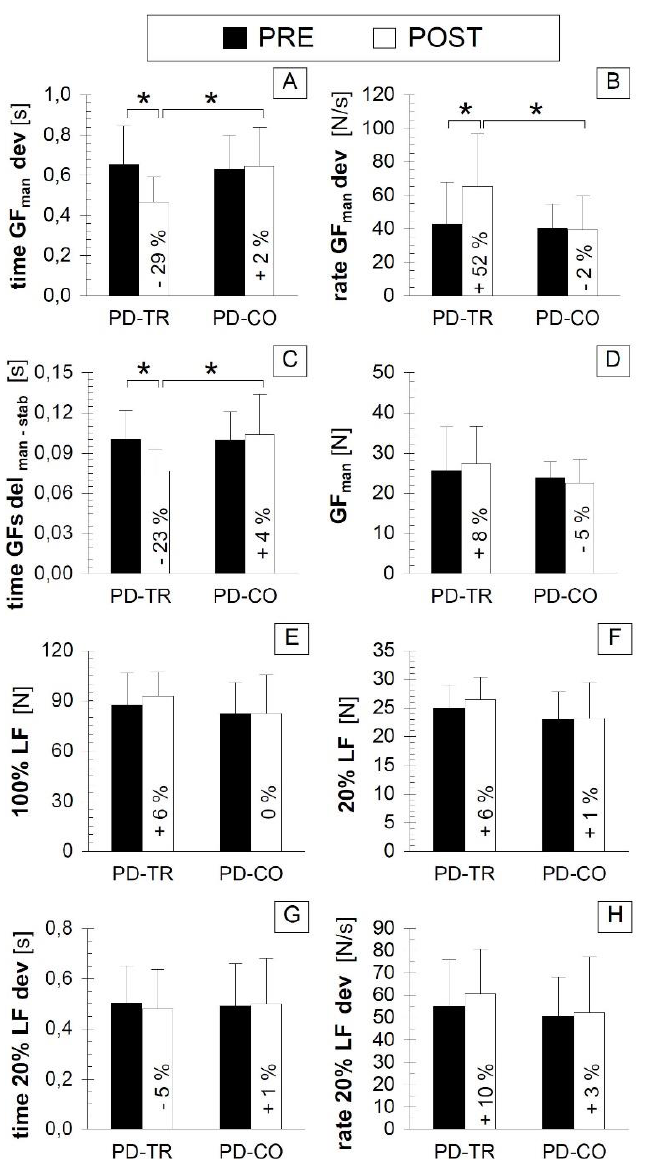
Figure 3. Comparison of the bimanual motor control outcomes between the two testing sessions and the two tested groups. ( A ) panel A presenting the values of time GFman dev; ( B ) panel B presenting the values of rate GFman dev; ( C ) panel C presenting the values of time GFs del man-stab ; ( D ) panel D presenting the values of GFman; ( E ) panel E presenting the values of 100% LF; ( F ) panel F presenting the values of 20% LF; ( G ) panel G presenting the values of time 20% LF dev; ( H ) panel H presenting the values of rate 20% LF dev. Abbreviations: PRE — testing session before the eight weeks of training; POST — testing session after the eight weeks of training; PD-TR — Parkinson ’s disease patients from the training group; PD-CO — Parkinson ’s disease patients from the control group; GFman — peak value of grip force in the manipulating hand during the 20% load force trial; time GFman dev — time taken for GFman development; rate GFman dev — rate of GFman development; time GFs del man-stab — time delay between the onset of grip force development in the manipulating hand and that in the stabilizing hand; 100% LF — the value of achieved maximal load force; 20% LF — the peak value of developed LF during the trial of 20% LF; time 20% LF dev — the time taken for 20% LF development; rate 20% LF dev — the rate of 20% LF development; the % value inserted into the bar of the POST session indicates the percentage value of the change between the POST and PRE testing sessions; * — statistically significant inter-testing session or inter-group difference at the p ≤ 0.05 level.